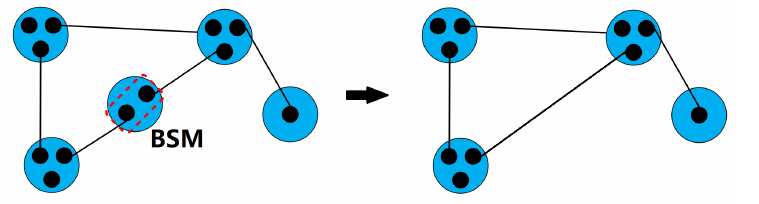
Figure 1. A general quantum network. Each black dot represents a qubit and each edge represents a pure partially entangled state. The blue circles, which include multiple qubits, are nodes of the network. By performing Bell State measurement (BSM), new entanglement can be constructed between two qubits and new edges are formed between two nodes.